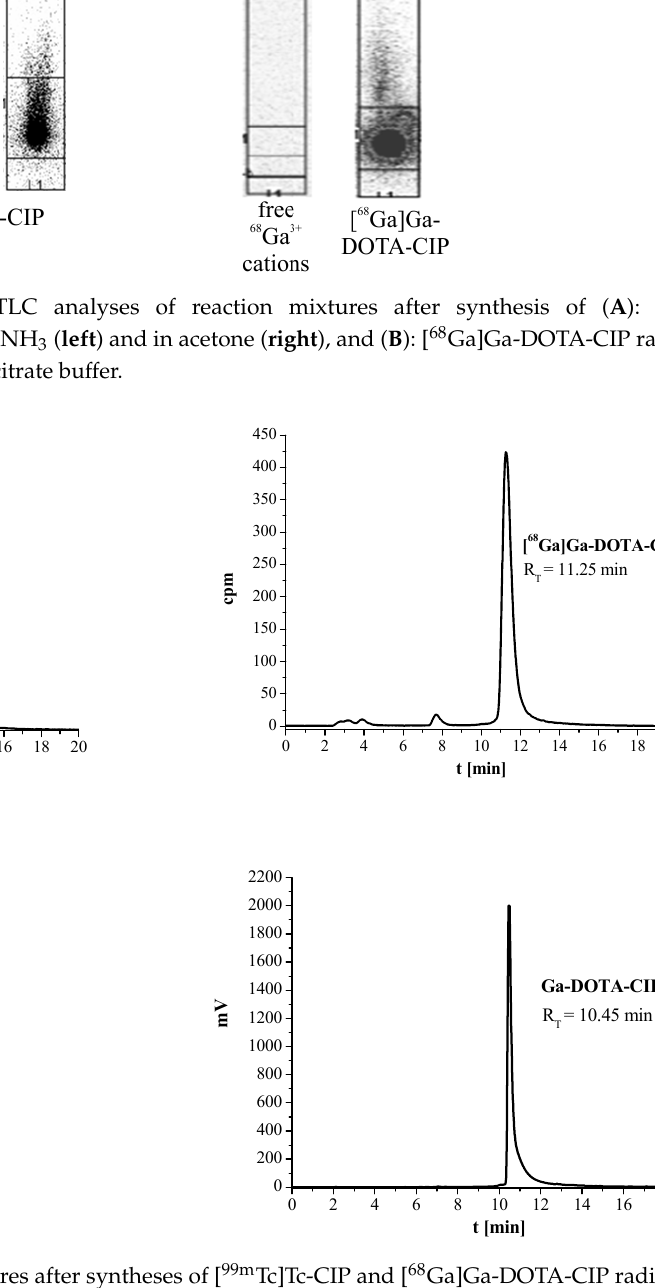
Figure 4. HPLC analyses of reaction mixtures after syntheses of [ 99m Tc]Tc-CIP and [ 68 Ga]Ga-DOTA-CIP radioconjugates, and cold reference compound Ga-DOTA-CIP.